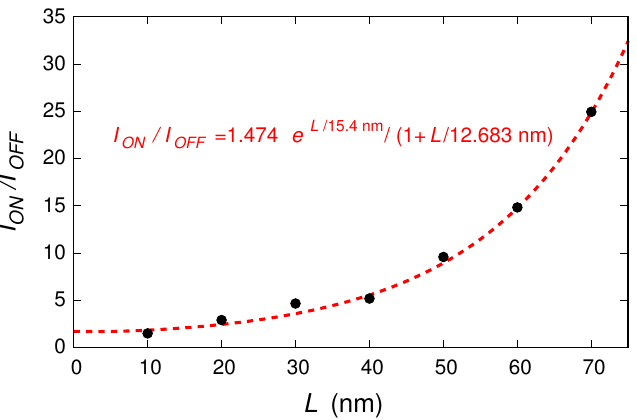
Figure 4. Average transfer characteristics (obtained for V DS = 0.1 V) of the double-gate field-effect-transistor based on a graphene ribbon with a 0.6% boron concentration over a length of 10, 20, 30, 40, 50, 60, and 70 nm. The current value was divided by the ribbon width W = 3.81 nm in order to represent the current density. The four vertical lines identify the values of V GS for which the values plotted in Figure 6 were extracted.